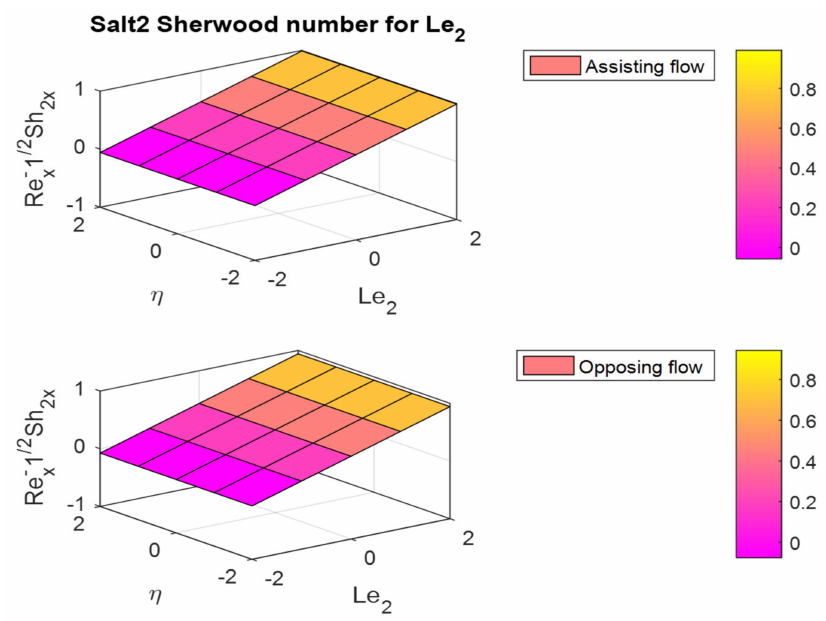
( 0 ) for dissimilar values of Le 2